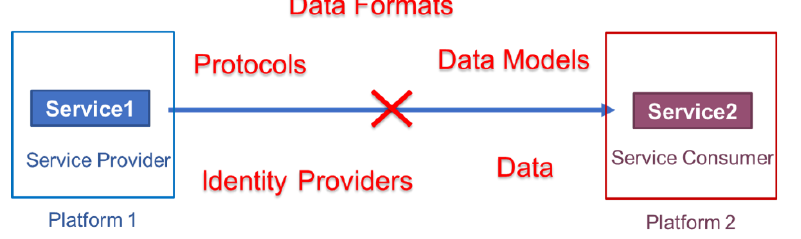
Figure 1. An illustration of interoperability gaps between services of heterogeneous Internet of Things (IoT) platforms.